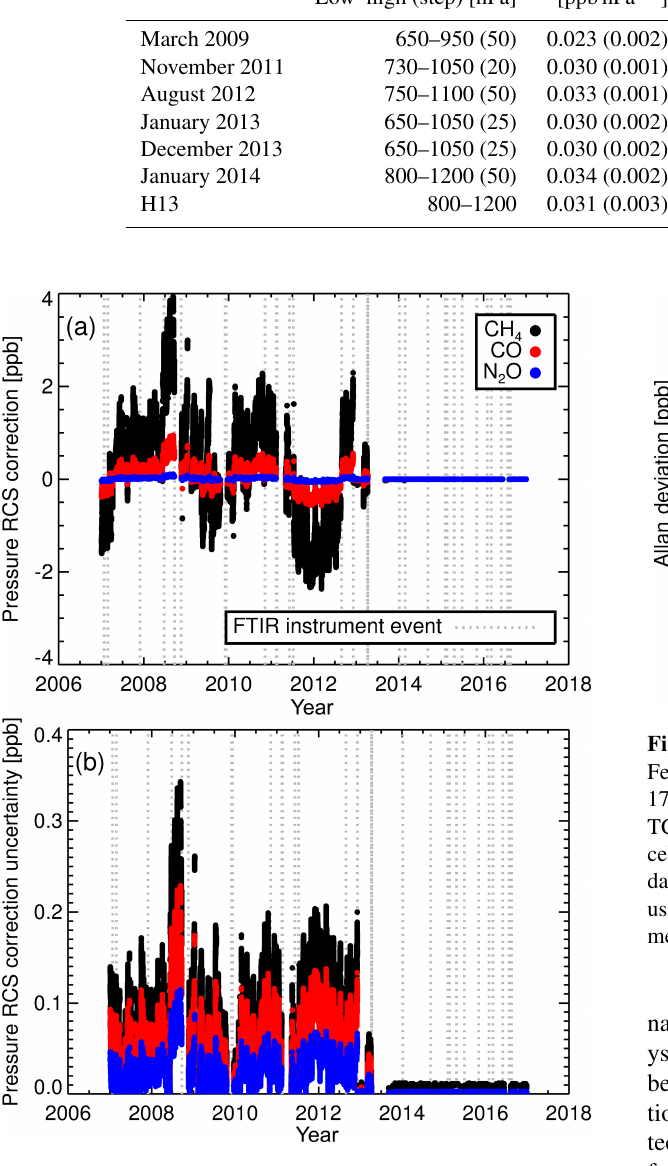
Figure 6. (a) RCS p corrections applied to the calculated CH 4 , CO and N 2 O dry mole fractions and (b) associated correction uncer- tainties.